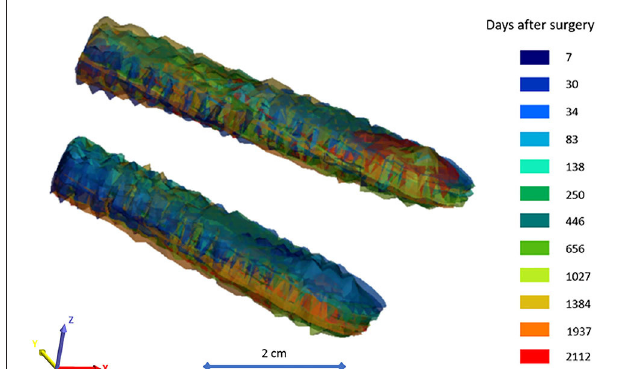
FIGURE 6 | Geometric overlap of the body of the iliac screws after the alignment process. The 12 postop CT scan-based surface mesh representing the iliac screw bodies are color-coded corresponding to the scale bar (color = CT scan session + number of days after surgery). The surfaces mesh is visualized with 75% transparency.